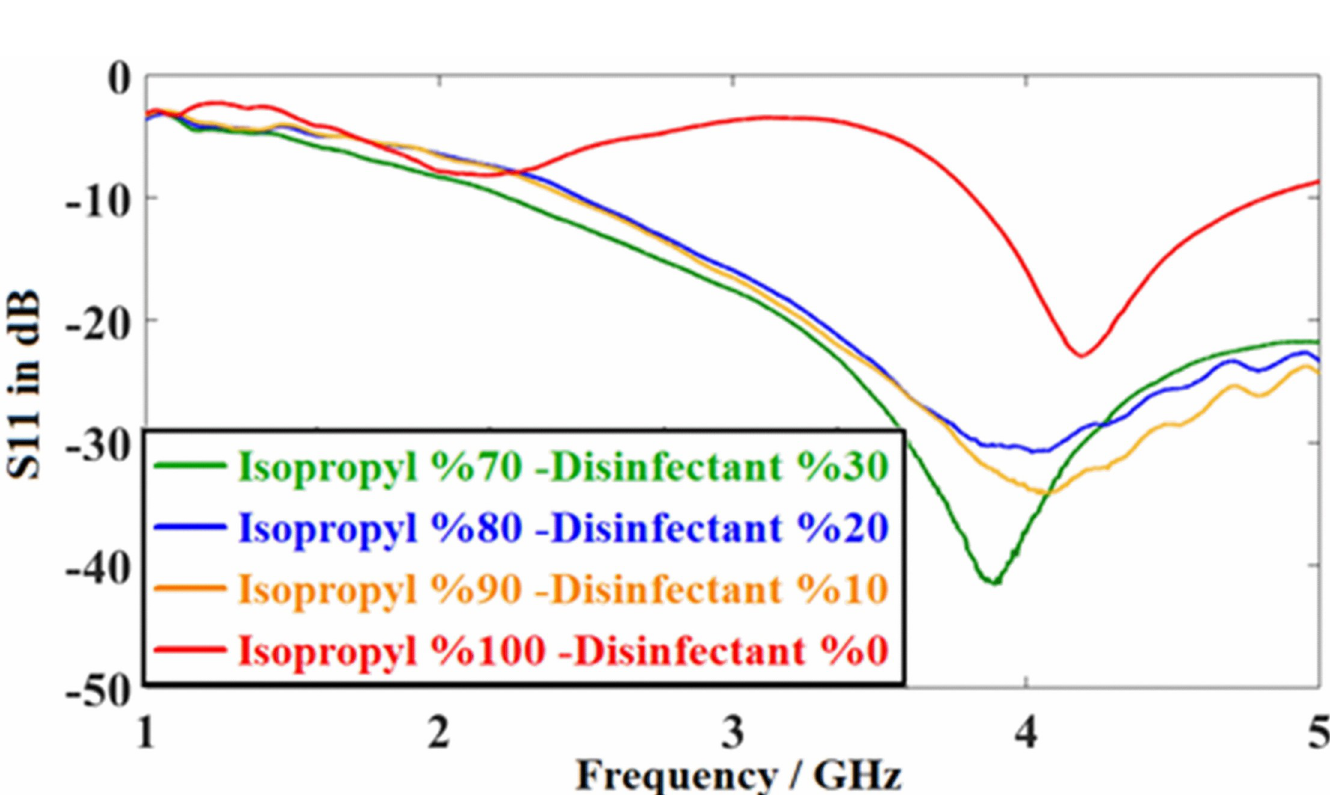
Fig 12. Measured results for the antenna sensor structure with disinfectant-isopropyl content.